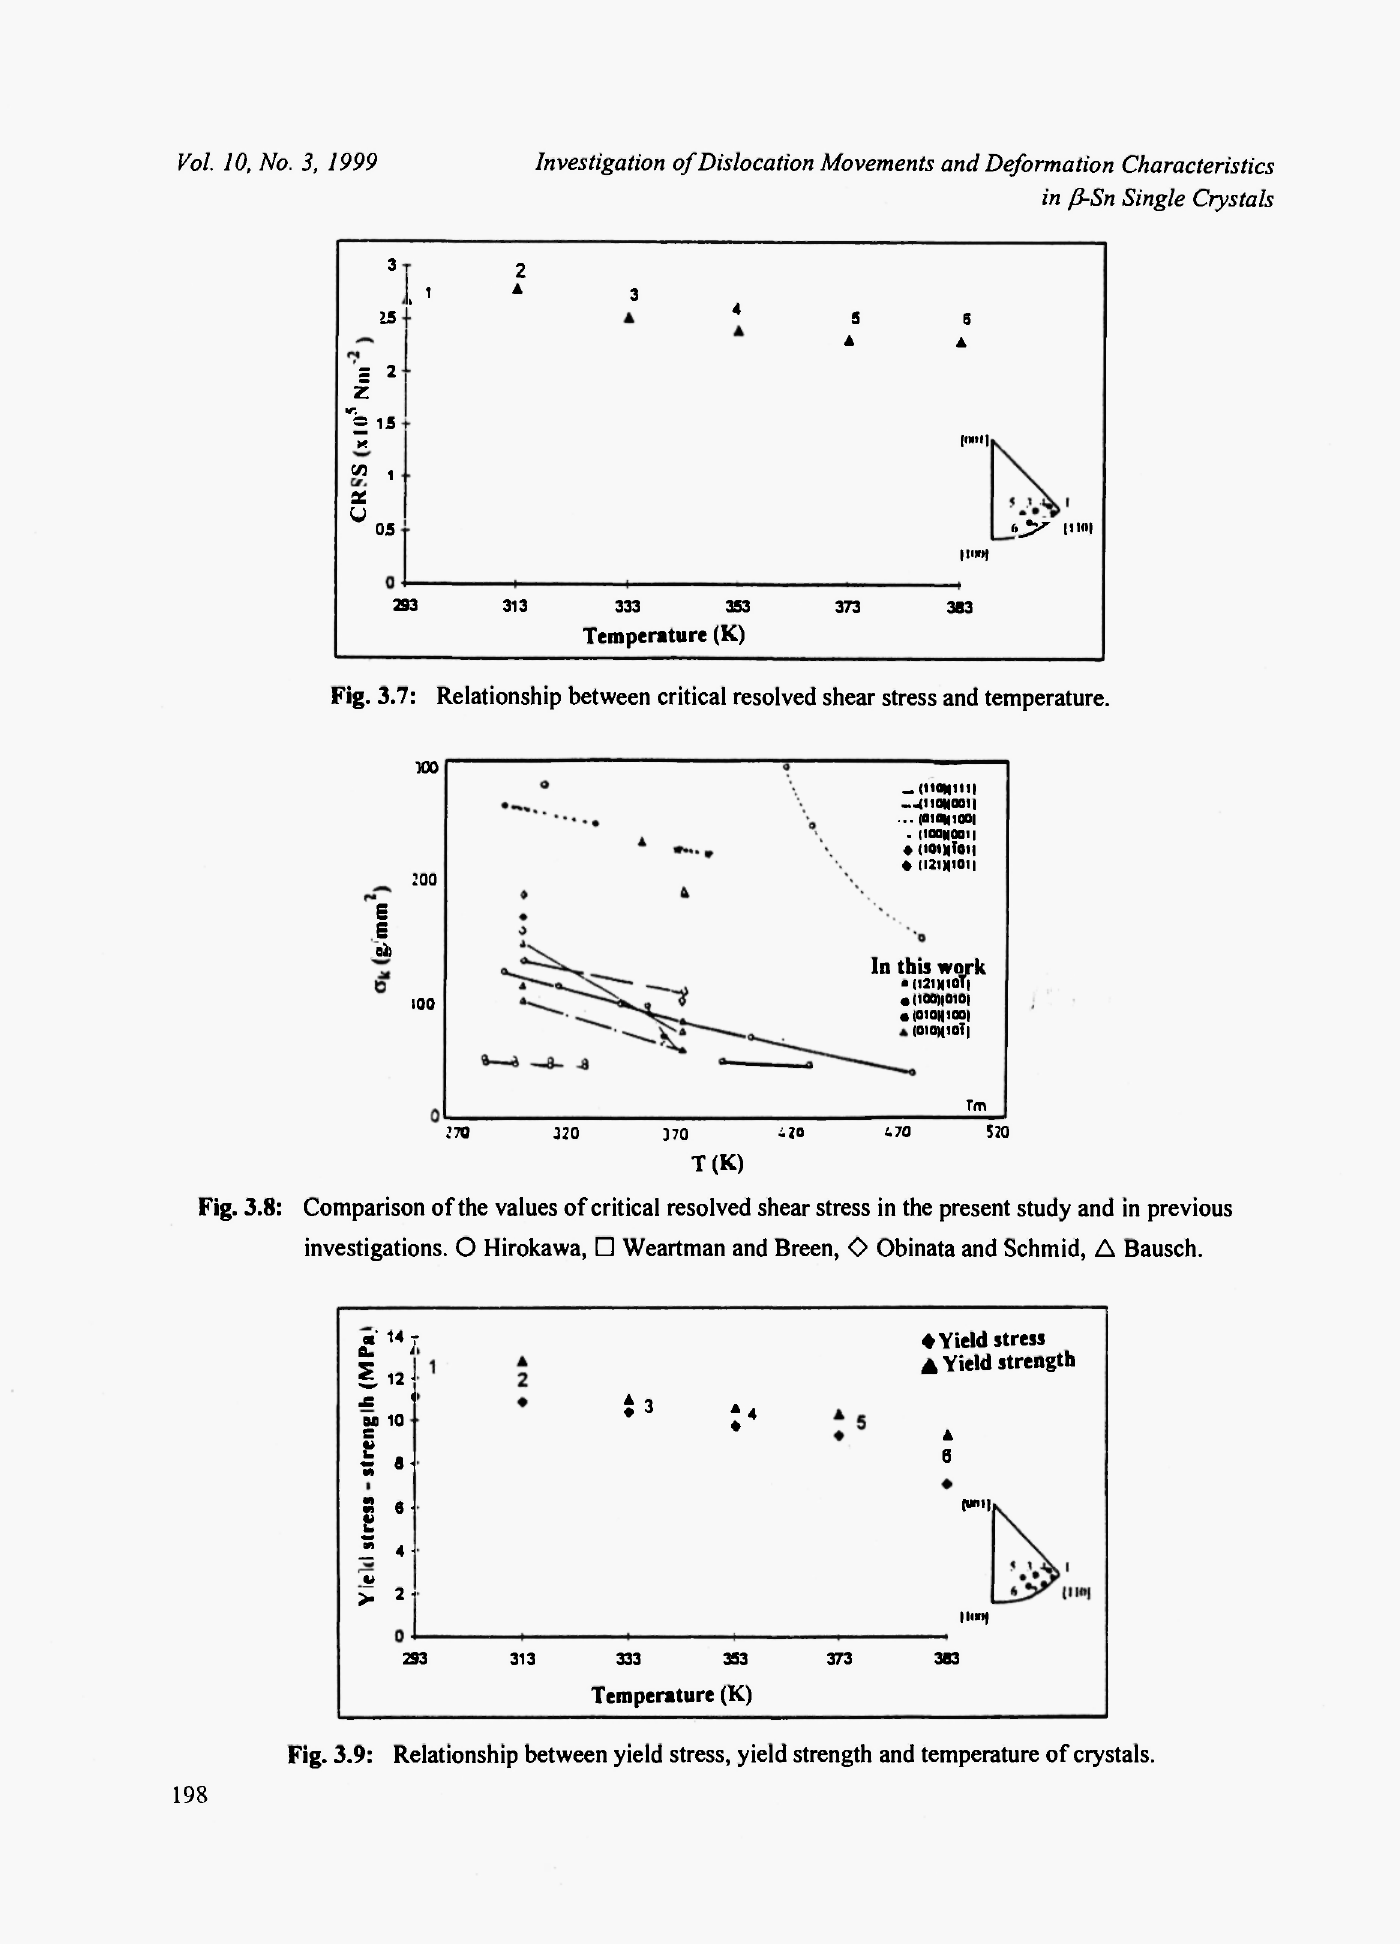
Fig. 3.9: Relationship between yield stress, yield strength and temperature of crystals.